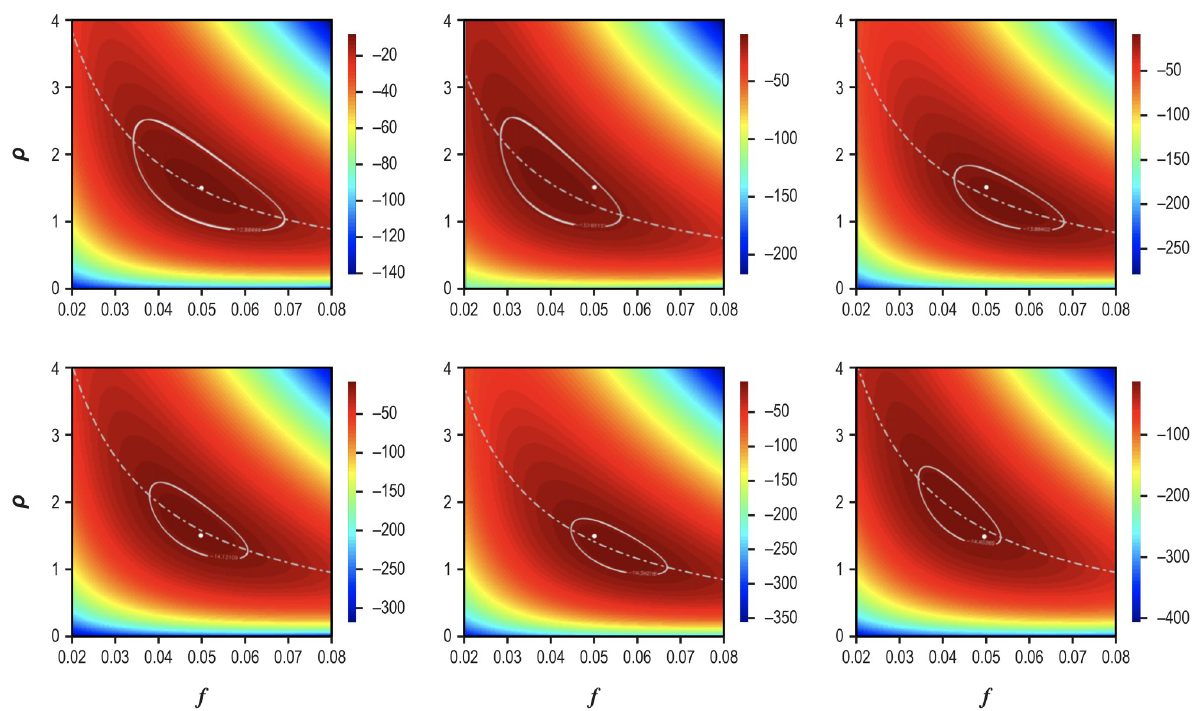
Fig 10. The consequences of varying test numbers and letting test data vary from the mean values of T represents f t and ρ t , and the dotted curve is the function ρ ( f ) described in the caption to the previous figure and which now depends on the test results. The upper left panel reproduces Fig 9, in which T = 1500 and the test data are the mean values of T random realization of the simulation of the testing process and going clockwise from the upper left panel, T = 2000, 3000, 3500, 4000, and 4500.